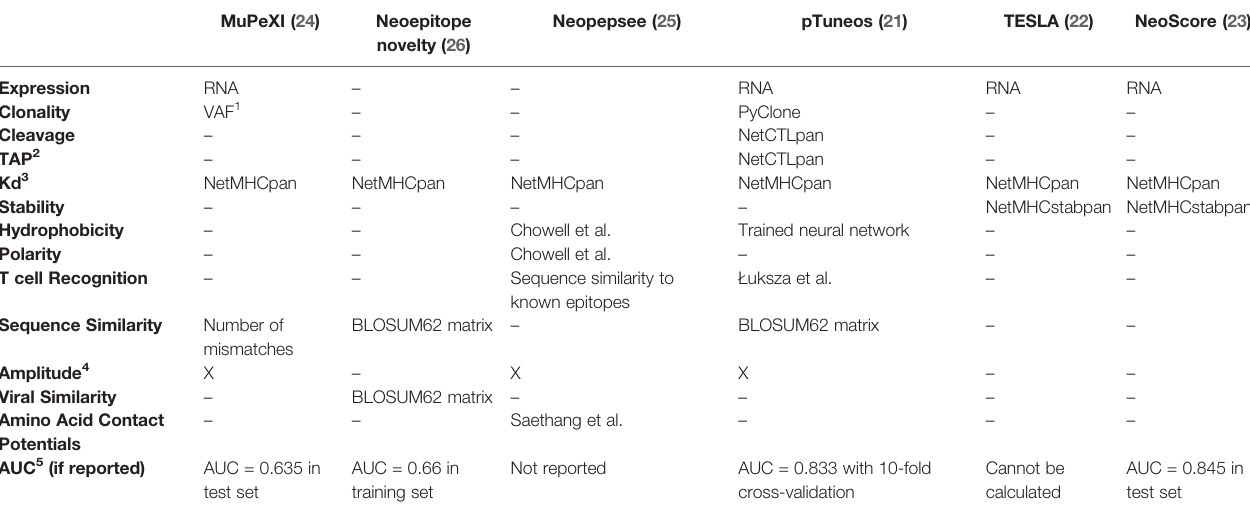
TABLE 4 | Summary of MHC class I-restricted neoantigen prioritization